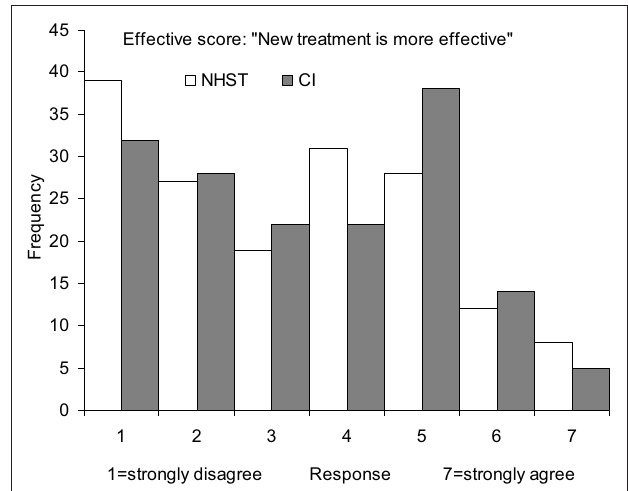
Figure 6 | Frequency histograms of effective scores in experiment 1. Responses indicate strength of agreement the two studies described in Figure 1 together provide evidence the new treatment is more effective. Histograms are shown for the two NHST display formats combined, and the two CI formats combined – in each case for all three disciplines combined.